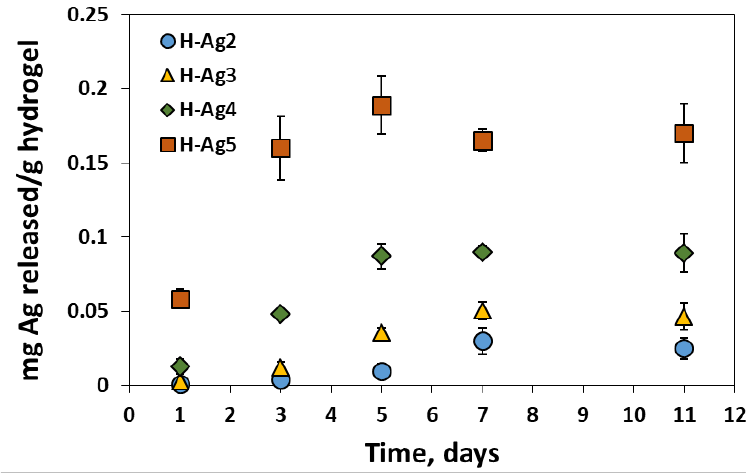
Figure 8. Release profiles of silver from the composite hydrogels in simulated physiological conditions (PB pH = 7.4 and 37 °C).